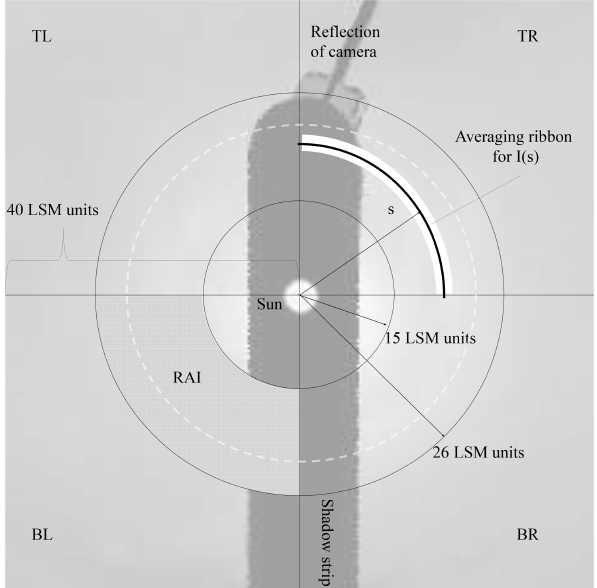
Figure 3. Layout of the local sky map (LSM). The LSM is divided into four quadrants, named according to their position as TR – top right, BR – bottom right, BL – bottom left, and TL – top left. The RAI is the radial analysis interval for which PST and IHS properties are evaluated. The approximate position of the halo maximum is sketched in light gray. Shadow strip and camera are excluded from